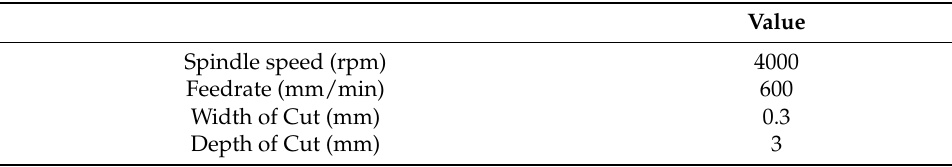
Table 5. Cutting parameters for experiment